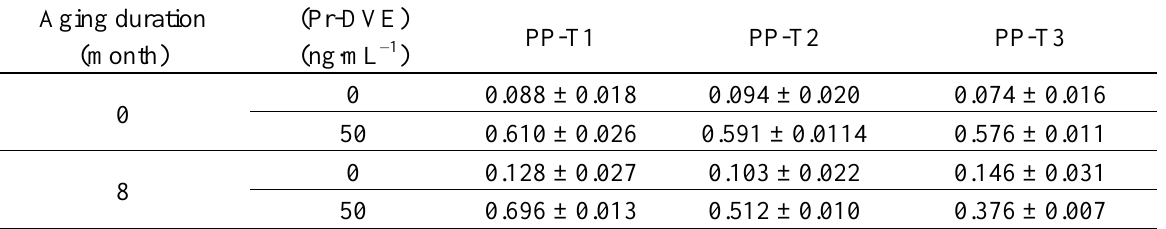
Table 1. Aging of the ELISA well measured by Pr-DVE titration (optical density).